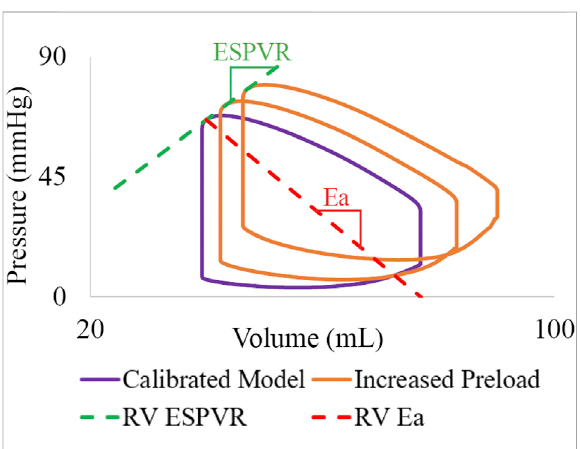
FIGURE 7 Metrics derived from the high-resolution ventricular